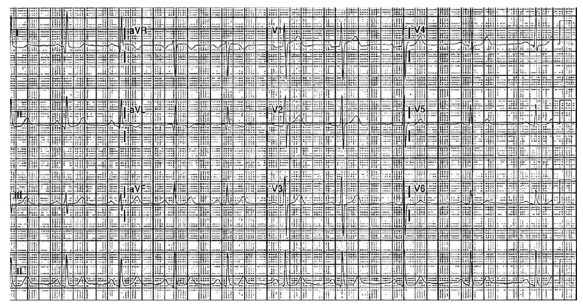
Figure 1: ECG at admission shows left ventricular hypertrophy pattern with unspecific ST-T wave